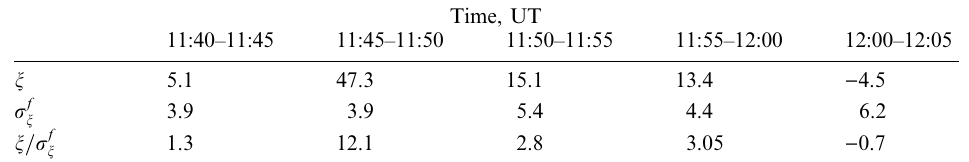
Table 3. The weighted